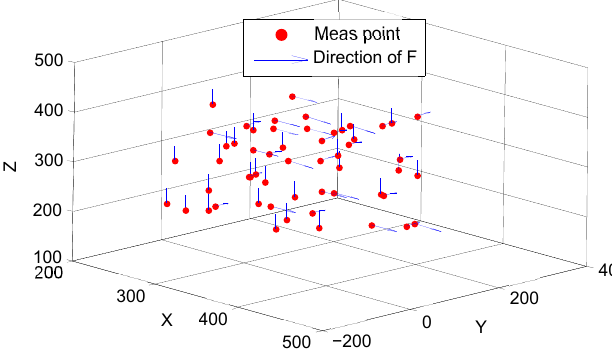
Figure 6. The measured points and the directions of their applied force.